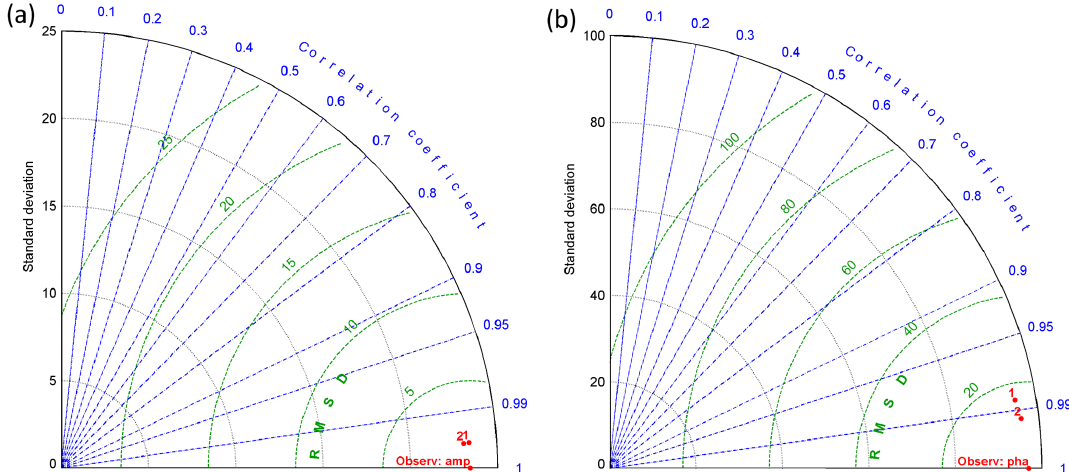
Figure B1. Taylor diagrams based on observed and modelled data at three gauging stations, “1” and “2” indicate simulation results on curvilinear and unstructured grids, respectively: (a) for amplitude; (b) for